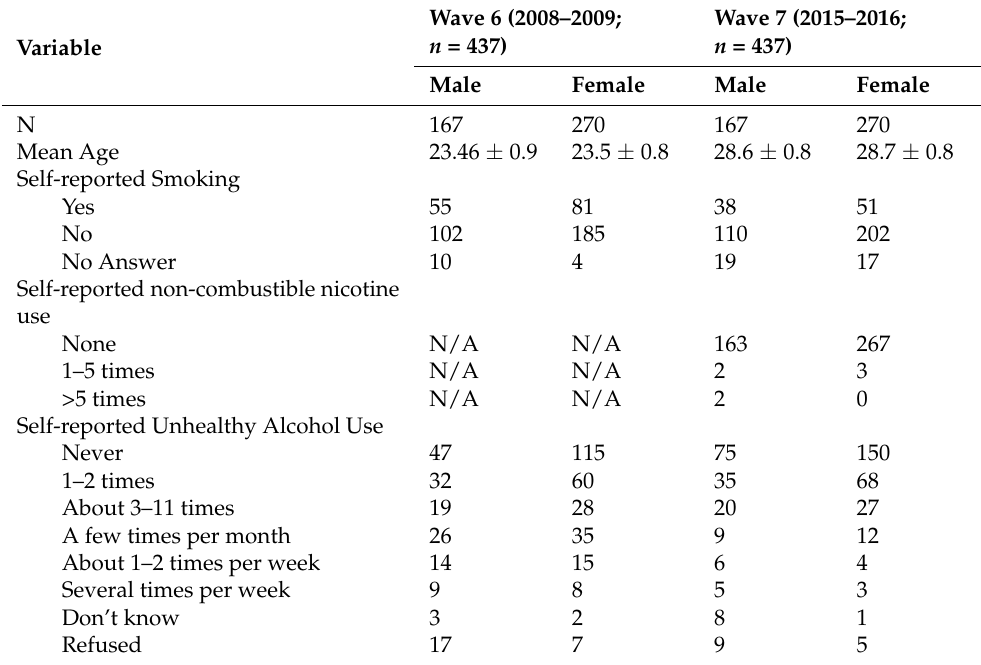
Table 1. Wave 6 and Wave 7 demographic, physiologic and self-report data.